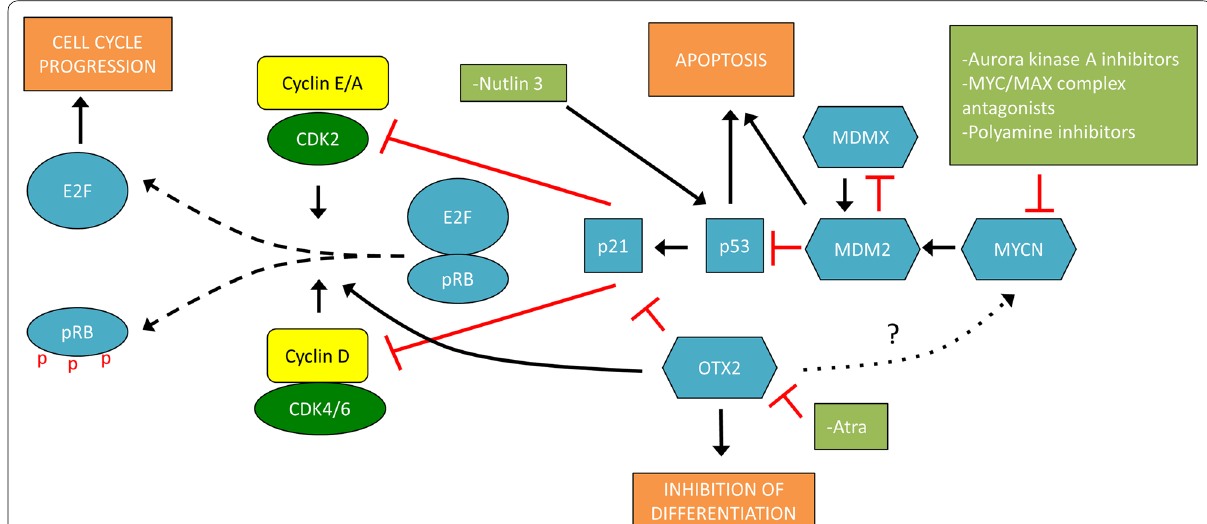
Fig. 4 Overview of the molecular pathways involved in regulating the cell cycle, differentiation and apoptosis. Different strategies have been pro‑ posed for direct and indirect targeting of p53, MYCN and OTX2 in retinoblastoma. Nutlin‑3 has been shown to stabilize p53. Taking inspiration from neuroblastoma treatments, MYCN activity can be blocked by disruption of the MYCN/MAX dimerization complex, or introduction of MYCN protein destabilization via aurora kinase A inhibitors. Pharmacologic inhibition of OTX2 activity via all‑trans retinoic acid (ATRA) can increase differentiation and apoptosis and decrease proliferation in cancer